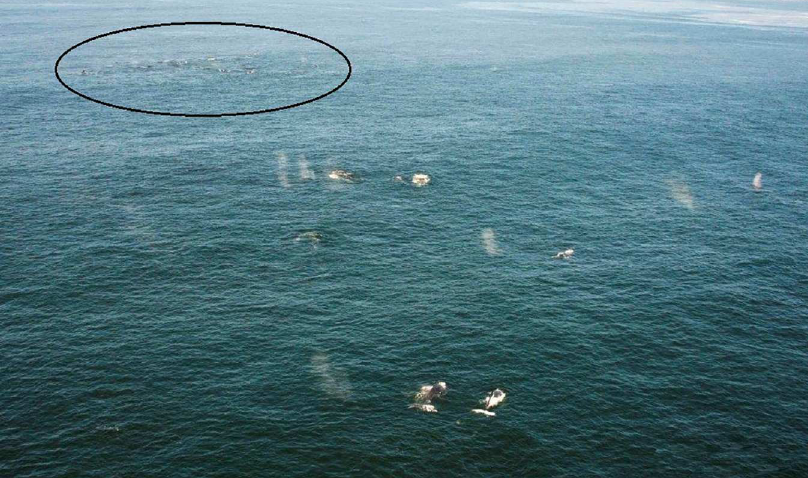
Fig 3. An aerial incidental observation of a “super-group” (Observation 3 Table 2, circled in background) within a widely distributed loosely-spaced aggregation of smaller feeding sub-groups (foreground) off Dassen